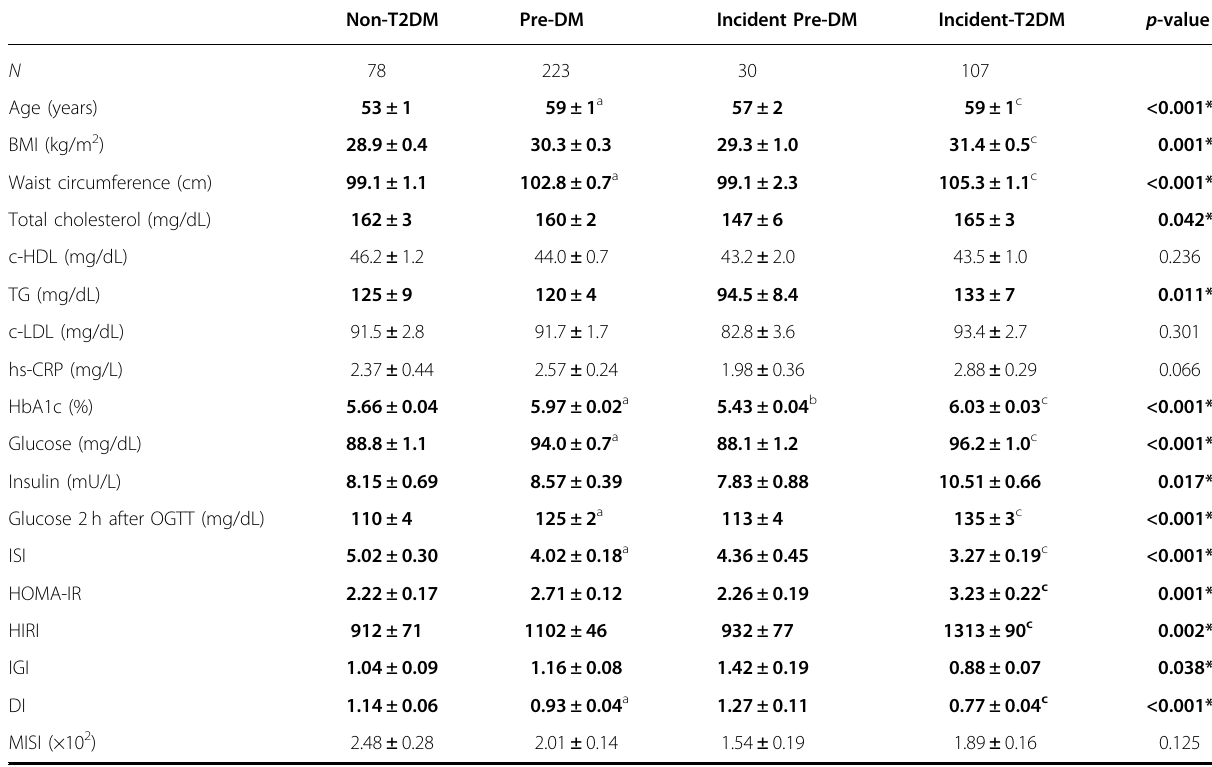
Table 1 Baseline characteristics of different groups of patients included in the